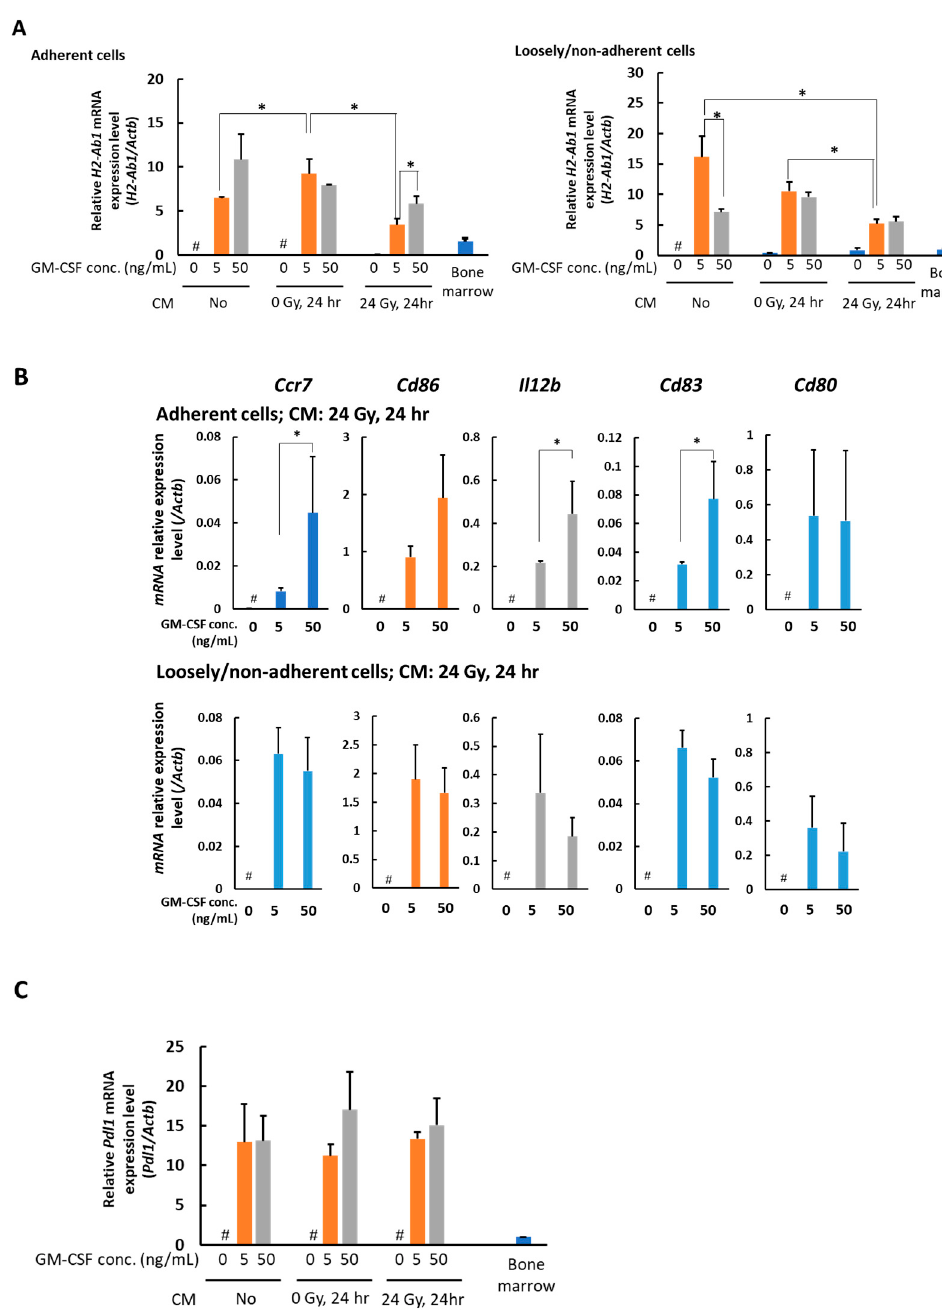
Figure 3. Real-time PCR analysis of the expression level of the genes involved in antigen presentation in the adherent and loosely/non-adherent cells. ( A ) H2-Ab1 mRNA expression level. ( B ) Ccr7 , Cd80 , Cd83 , Cd86 , and Il12b mRNA expression levels. ( C ) Pdl1 mRNA expression level in the adherent cells. Bone marrow cells on day 6 after culture with different concentrations of GM-CSF and CM obtained from non-irradiated or 24 h after 24 Gy γ -irradiated B16 cells. Mean ± SE, n = 3. *, p < 0.05. #, no living cells.